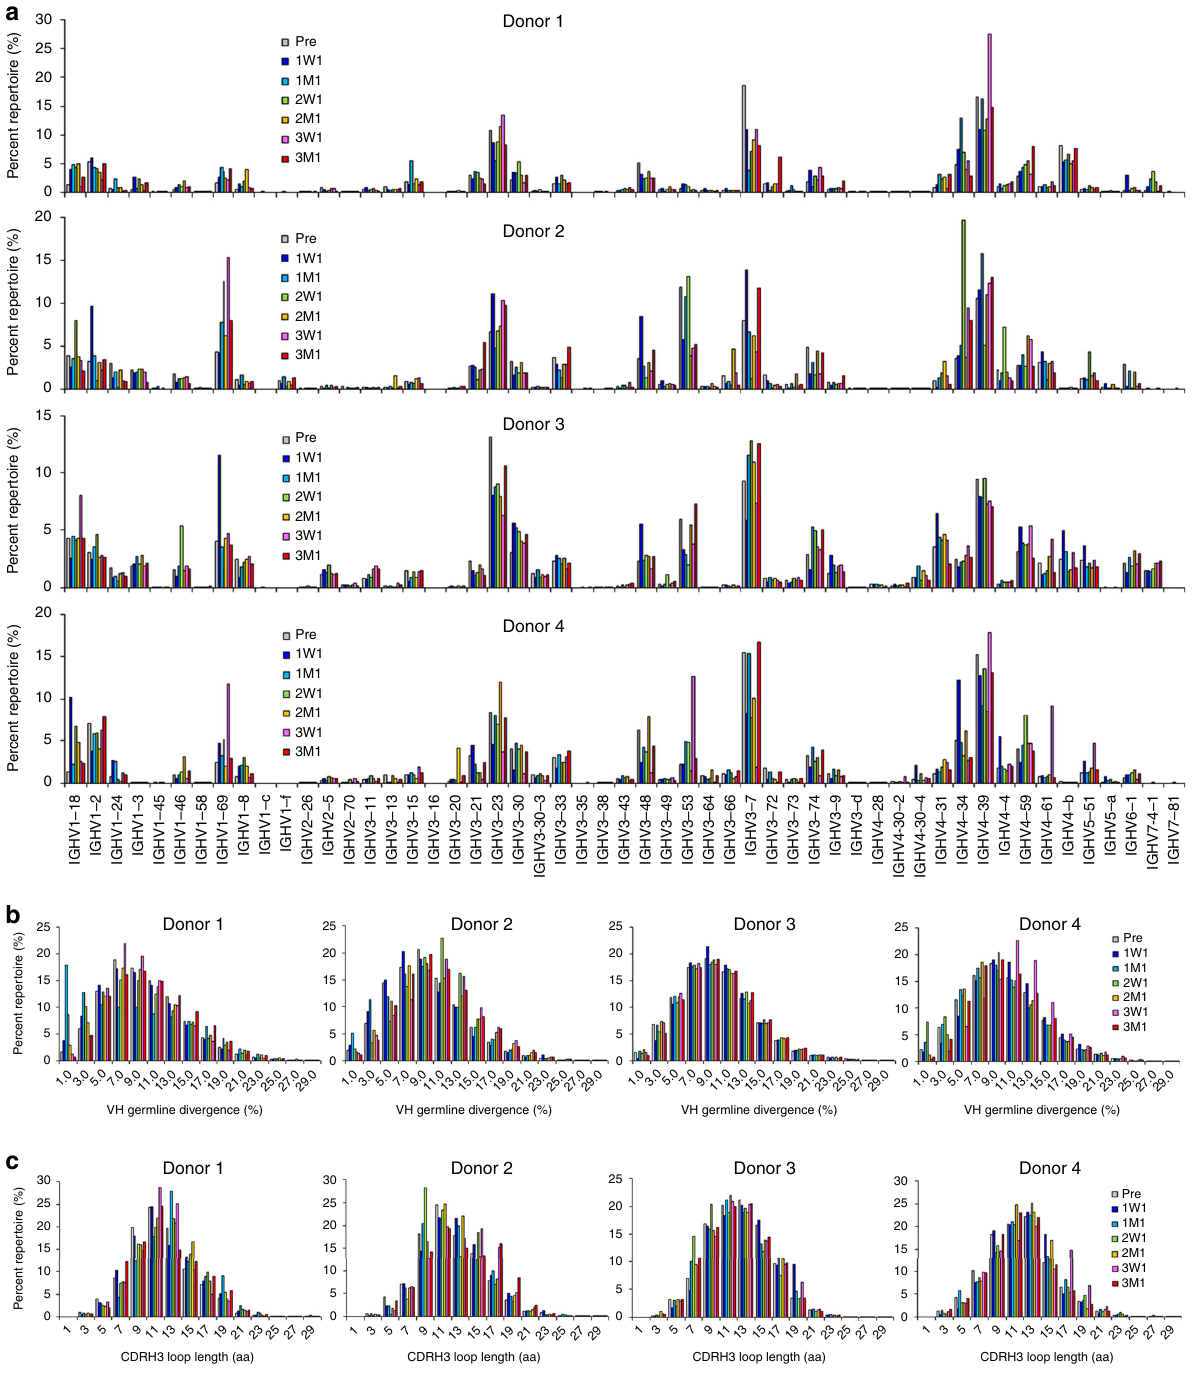
Fig. 4 Unbiased analysis of B-cell repertoire response during the course of vaccination. For each donor, the temporal distribution is plotted for ( a ) heavy- chain variable (VH) germline gene, ( b ) VH-germline divergence, or degree of somatic hypermutation (SHM), and ( c ) heavy-chain complementarity- determining region 3 (CDRH3) loop length. Pre: pre-vaccination; 1W1: 1 week after the fi rst dose; 1M1: 1 month after the fi rst dose; 2W1: 1 week after the second dose; 2M1: 1 month after the second dose; 3W1: 1 week after the third dose; 3M1: 1 month after the third dose. The color-coding scheme is described as follows: Pre (gray), 1W1 (blue), 1M1 (cyan), 2W1 (green), 2M1 (orange), 3W1 (purple), and 3M1 (red). Source data are provided in the Source Data fi